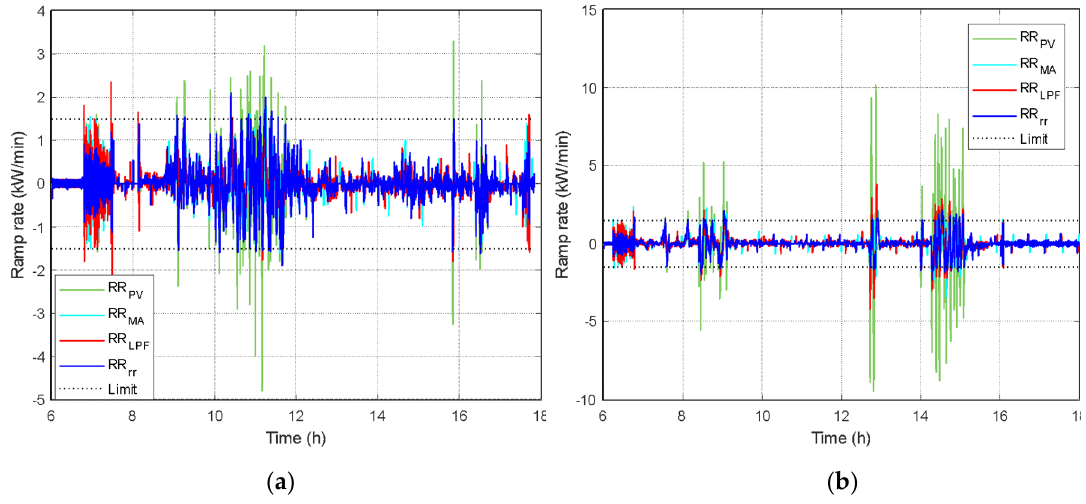
Figure 12. Rate of change of the energy injected into the PCC: ( a ) the intermediate fluctuation day (23 November 2018) and ( b ) day with less fluctuation irradiance (24 November 2018).